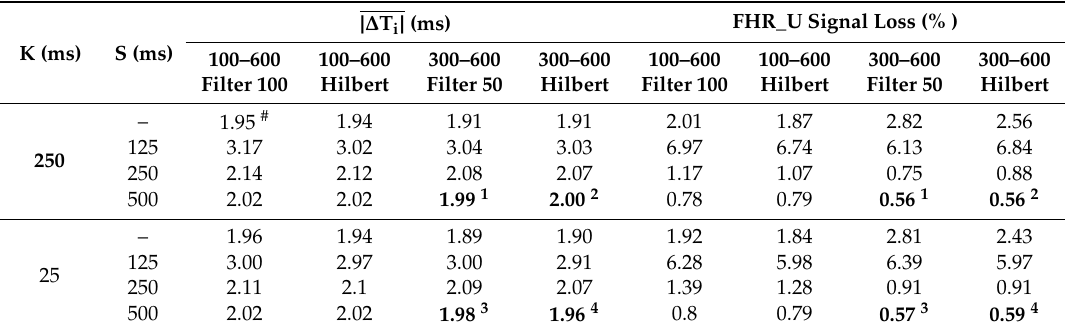
Table 2. Interval measurement errors and signal loss level in the FHR_U for two AF repetition cycles K (25 and 250 ms), using the PF with di ff erent window widths S or without PF. Four combinations of US signal bandwidths and four envelopes were considered.